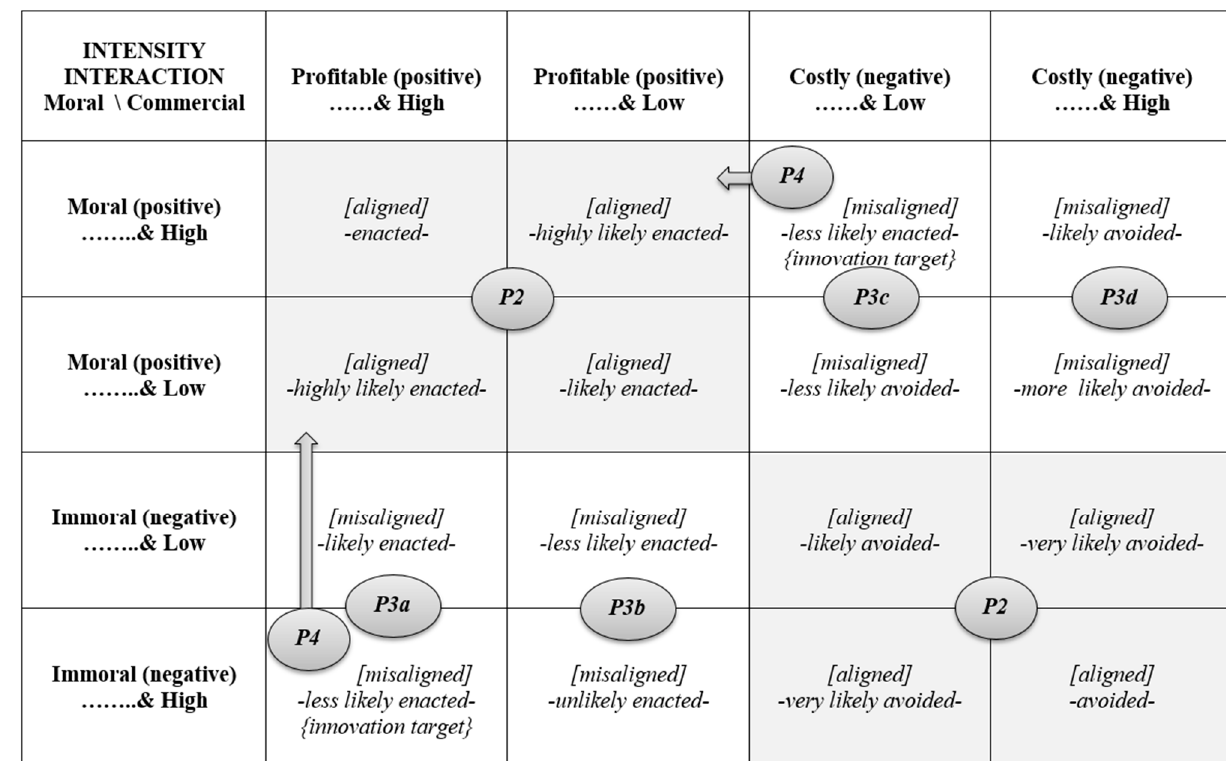
Figure 2. The Combinations of Intensity Interactions with Corresponding Propositions. When the alignment is positive, the entrepreneur-as-decision-maker and her orga- nization have the incentive to act. The opportunity is most likely to be enacted (i.e., commercialized in a moral, socially beneficial manner) when the intensity levels are both high, less so when only one is high, and much less so when both are low. The likelihood of enactment is explained by the stakes involved. In this case, doing good is doing well and being ethical makes money. This can occur when waste reduction also is cost reduc- tion (Porter and Linde 1995), or when the socially responsible action can be leveraged to differentiate a product (e.g., the Body Shop in cruelty-free cosmetics; Bombas in socks and apparel; Starbucks in ethical sourcing), or when an efficiency improvement not only saves money but reduces pollution (e.g., Walmart’s investment in solar and high-efficiency lighting), or when a new supplier is not only cheaper but also employs a disadvantaged group (e.g., Greyston Bakery), or when an application of the opportunity’s new technology helps the environment or the community (e.g., smart grids and smart meters; reduced packaging; the use of recycled materials; Zhangzidao Fishery Group’s integrated multi- trophic aquaculture farming method; Shree Cement’s intelligent energy heat-capturing process; Natura’s use of sugarcane-based plastic), or when some proceeds are diverted to charity (e.g., Bixby; Roma; Soapbox; Warby Parker). When the market logic is reinforced by the social logics (e.g., in legitimacy, in values, in culture) then decision-makers (and their organizations) are more likely to follow its direction (Zhao and Lounsbury 2016), so if the opportunity is expected to make a profit and satisfy the community, then it is more likely to be enacted. When the commercial desirability of the opportunity is matched with feasibility-as-social-support, then the likelihood of entrepreneurial action increases (Mc- Mullen and Shepherd 2006; Patzelt and Shepherd 2011). By contrast, when the alignment is negative then the entrepreneur-as-decision-maker and her organization have the incentive to not act (e.g., as both the social and economic returns are unattractive).